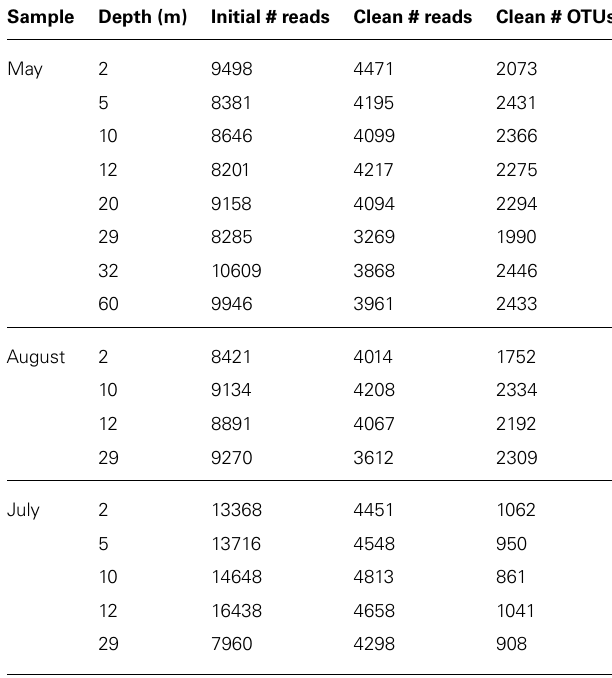
Table 2 |Total sequence and OTU yields for each